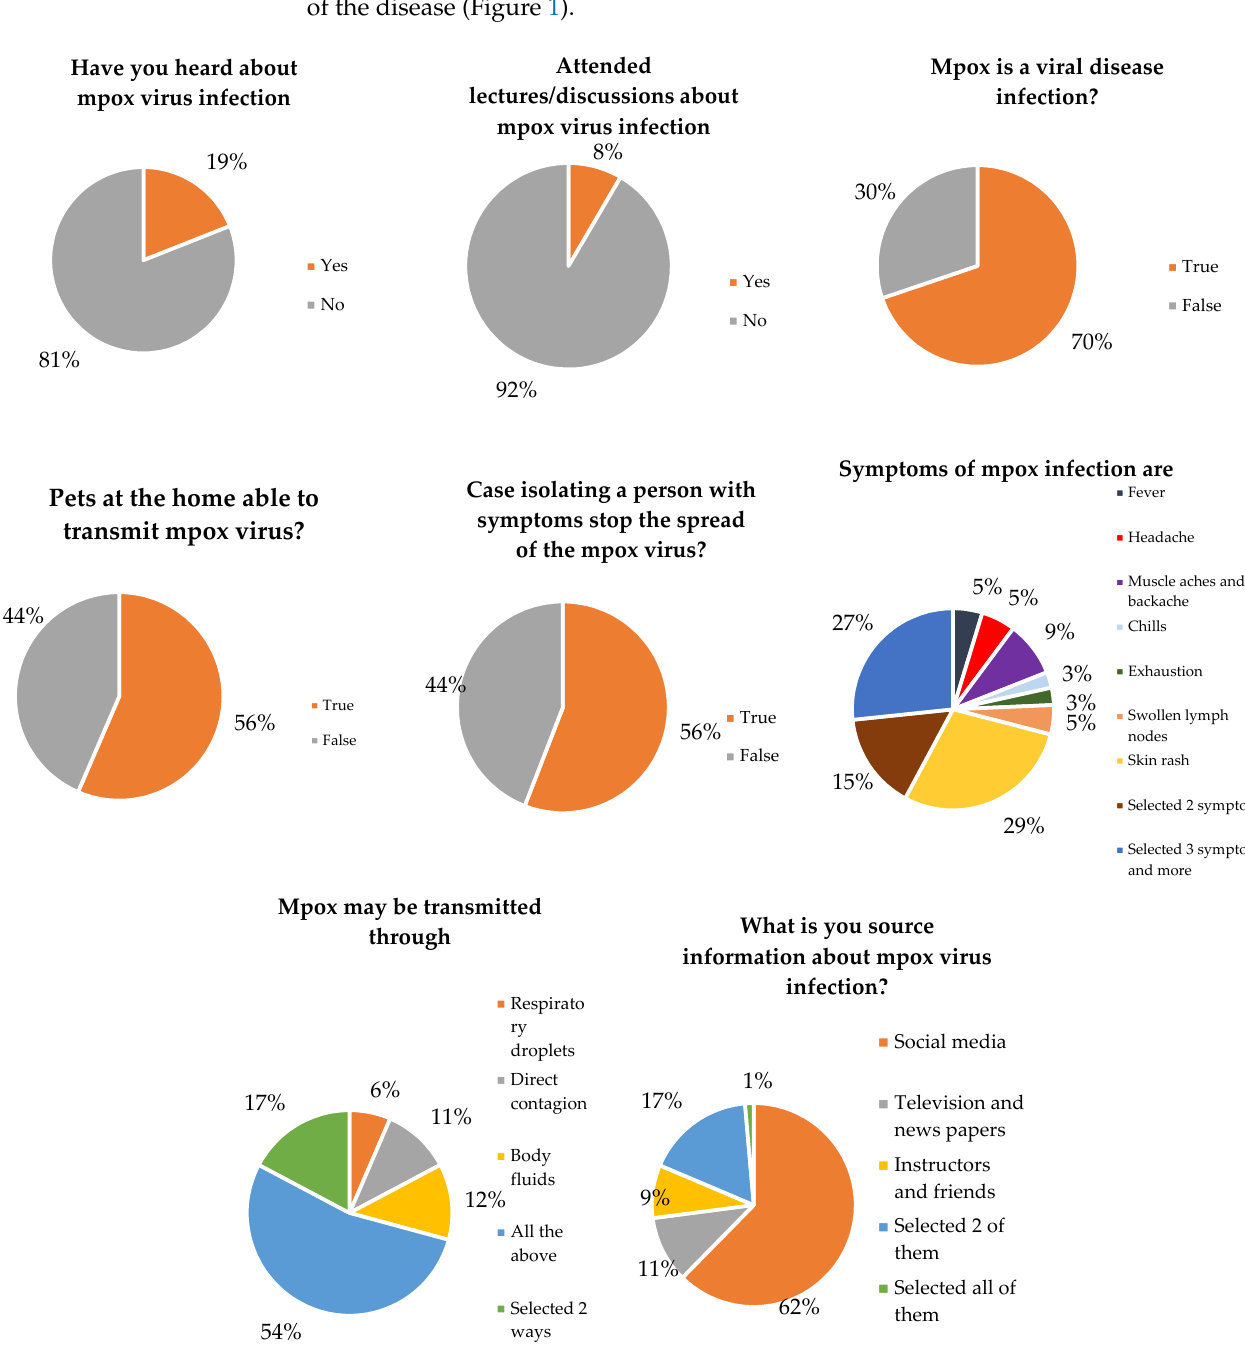
Figure 1. Knowledge of participants about mpox viral infection ( n = 510).